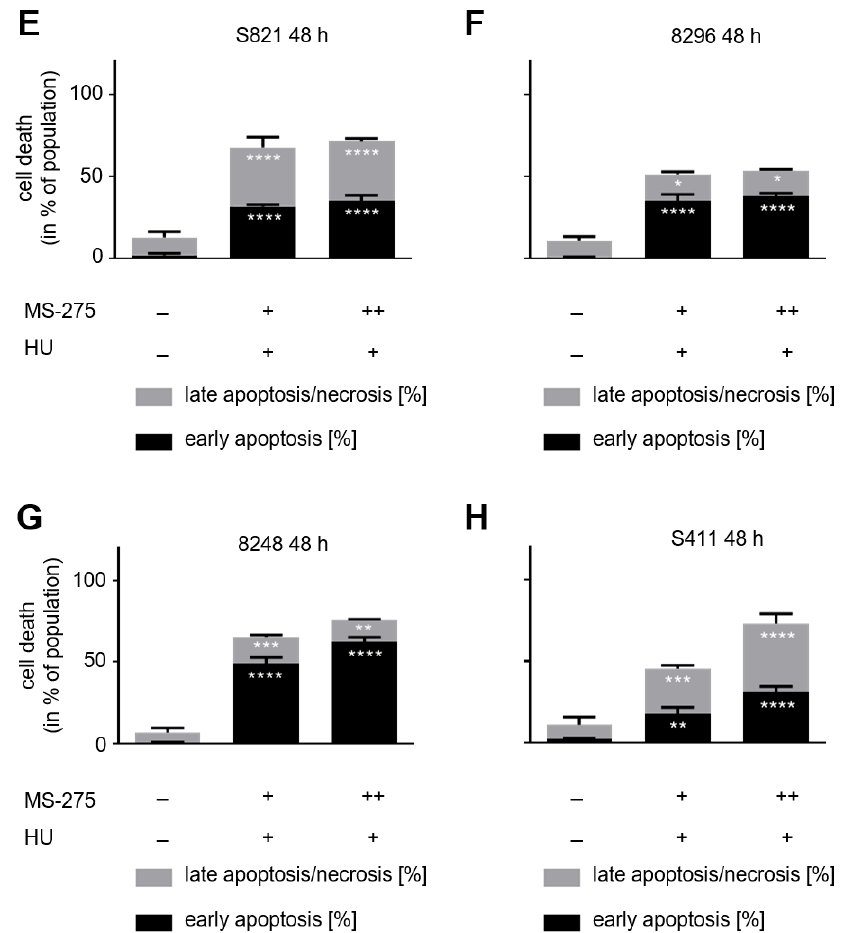
Figure 1. Apoptosis induction by hydroxyurea plus entinostat. PDAC cell lines were treated with various concentrations of entinostat (MS-275) and/or hydroxyurea (HU) for 24 h and 48 h. Cell cycle distribution and cell death were measured by flow cytometry of PI-stained cells. ( A ) S821, ( B ) 8296, ( C ) 8248, and ( D ) S411 cells were incubated for 24 h and 48 h with 1 µM (+), 5 µM entinostat (++), and/or 1 mM hydroxyurea (+). Data are mean ± SD values (24 h: n = 3; 48 h: n = 4). ( E – H ) The cells were treated with 1 µM entinostat (+) or 5 µM entinostat (++) plus 1 mM hydroxyurea (+) for 48 h and apoptosis was determined by flow cytometry for annexin-V/PI ( n = 3). Data were statistically analyzed using one-way ANOVA (* p < 0.05, ** p < 0.01, *** p < 0.001, **** p < 0.0001).